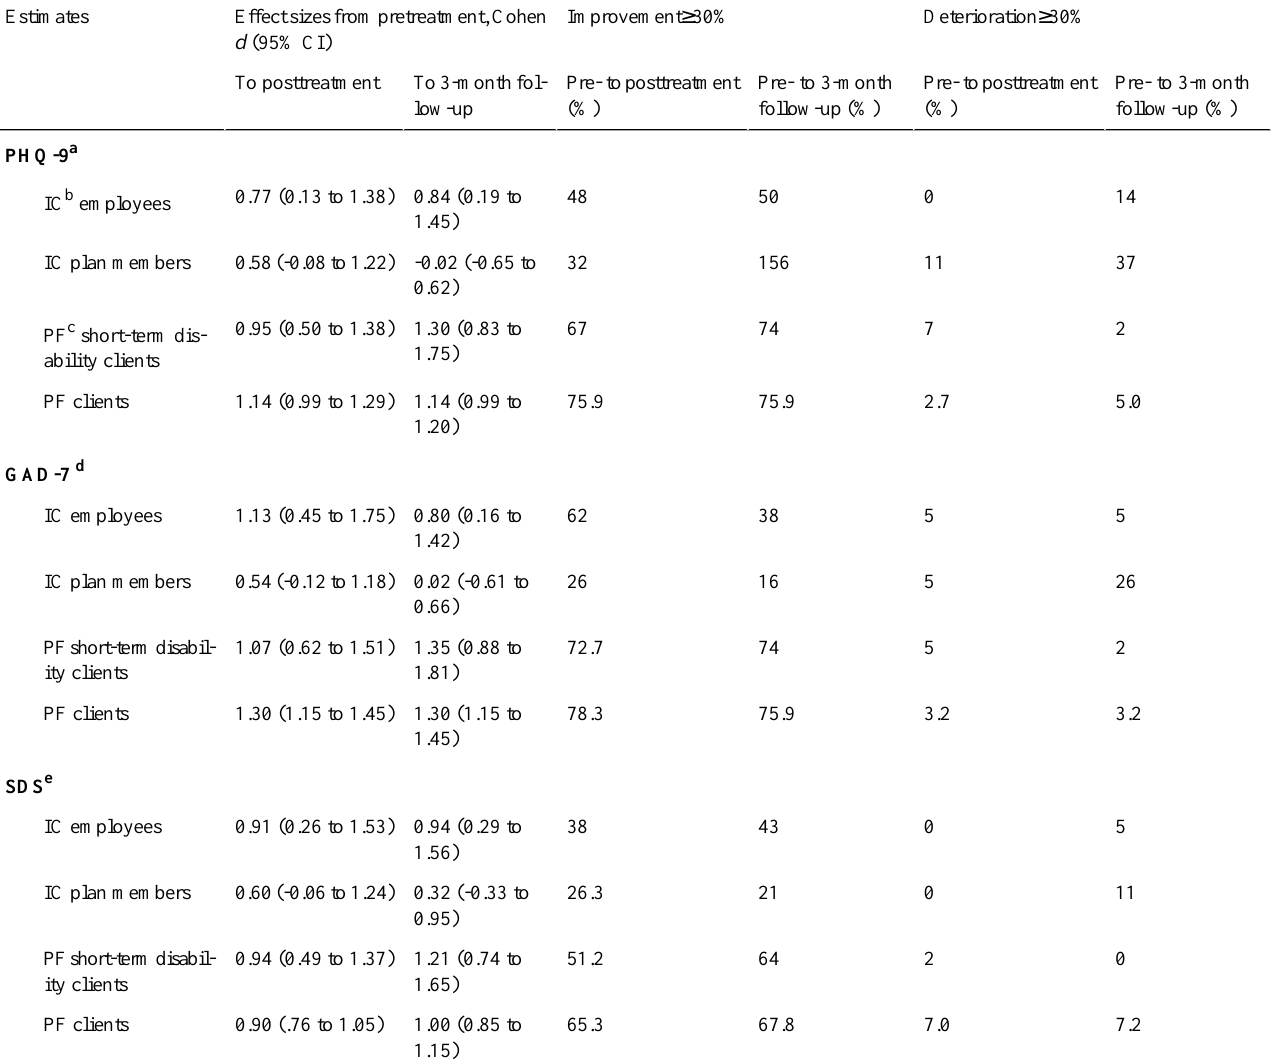
Table 3. Clinical reliable change from pretreatment to posttreatment and 3-month follow-up separated by